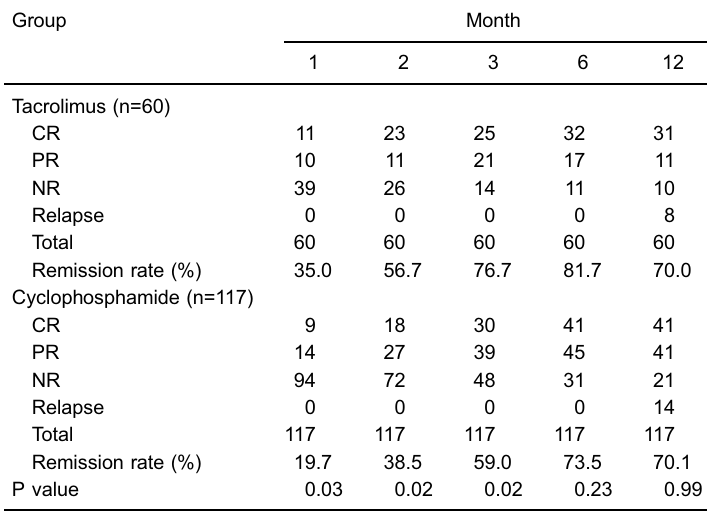
Table 2. Remission rates in idiopathic membranous nephropathy patients treated with tacrolimus or cyclophosphamide.